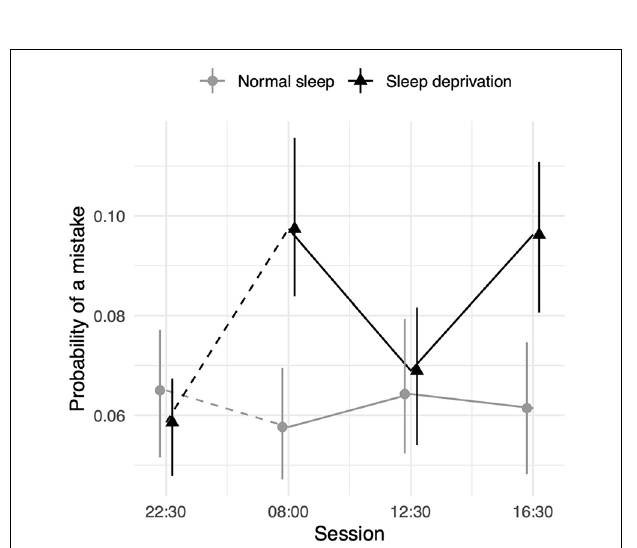
FIGURE 4 | Working memory test performance as measured by the probability of making a mistake depending on sleep condition and time of day. Dots represent fixed-effect estimates and error bars represent bootstrapped confidence intervals with 100 iterations. The dotted line between 22:30 h and 08:00 h represents the night. Sleepiness Sleep deprivation was found to lead to a significant increase in subjective sleepiness. Sleepiness was also decreased compared to baseline (22:30 h) in all three daytime sessions. An interaction between sleep deprivation and time-of-day was also observed. The effect of sleep deprivation on subjective sleepiness was found to be significantly lower in the morning (08:00 h), compared to the afternoon (16:30 h). Full results for